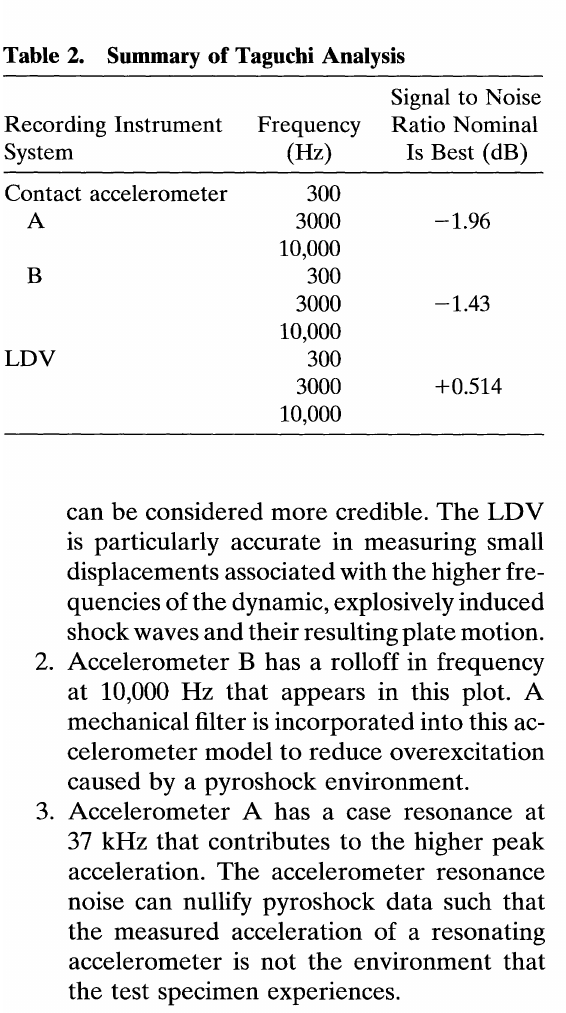
Table 2. Summary of Taguchi Analysis